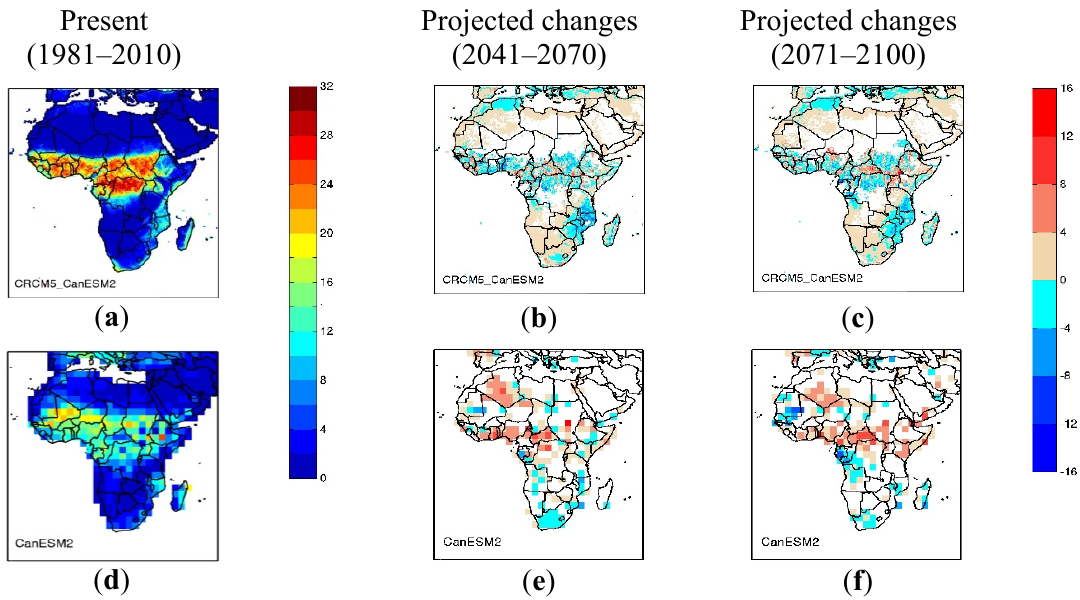
Figure 10. Same as Figure 6, but for the mean number of dry spells for boreal summer.